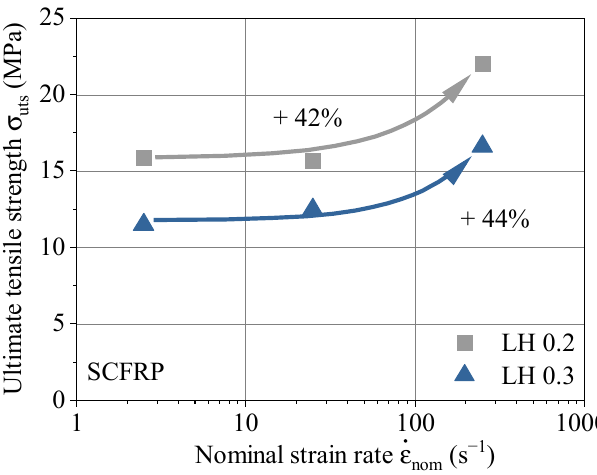
Figure 9. Ultimate tensile strength vs. strain rate for LH 0.2 and LH 0.3.